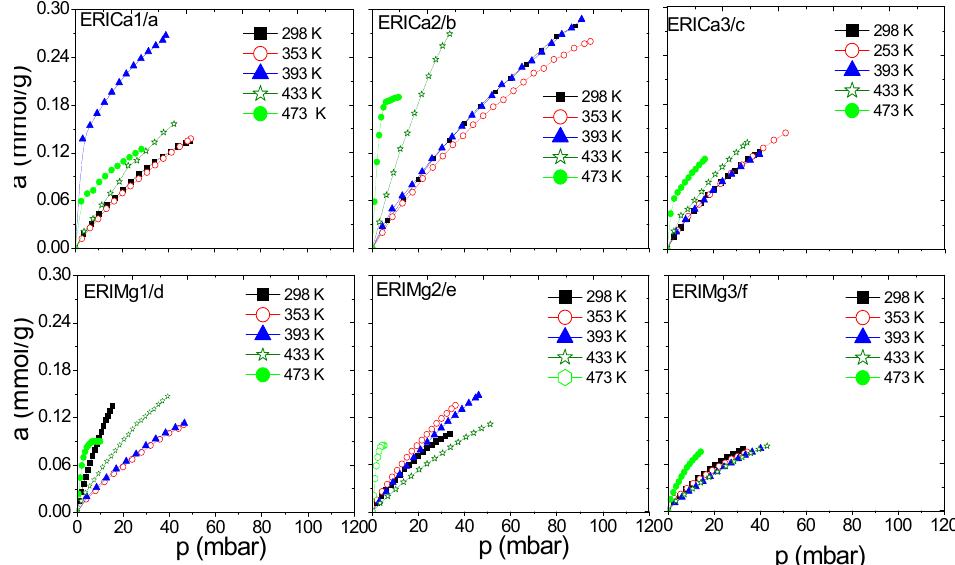
Figure 8. H 2 adsorption isotherms at different temperatures on: ( a ) ERIN, ( b – d ) ERINa1–3 exchanged zeolites.